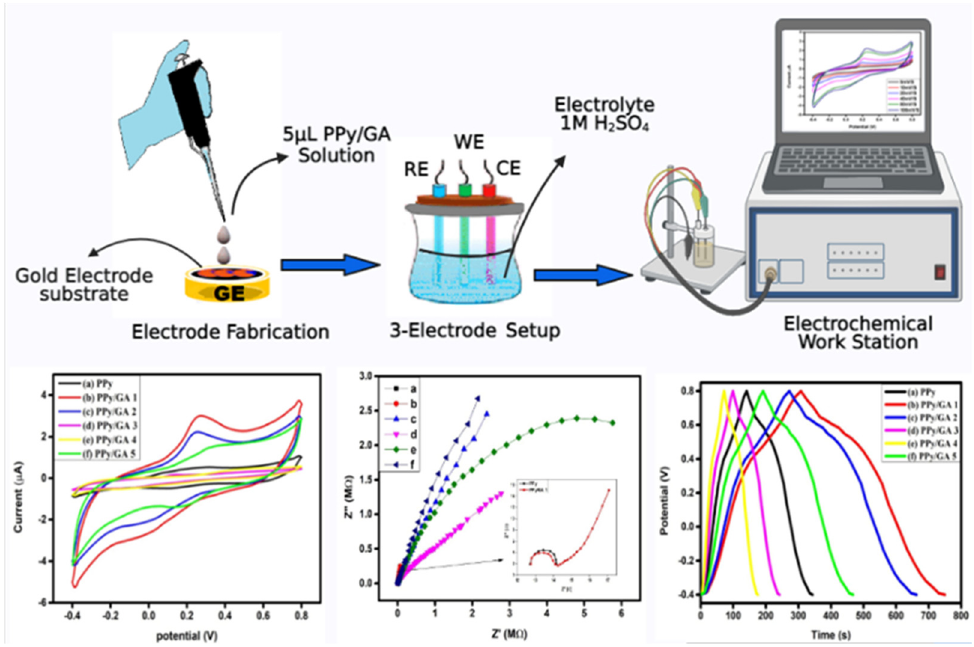
Figure 2. Schematic illustration of the electrode fabrication towards electrochemical properties.